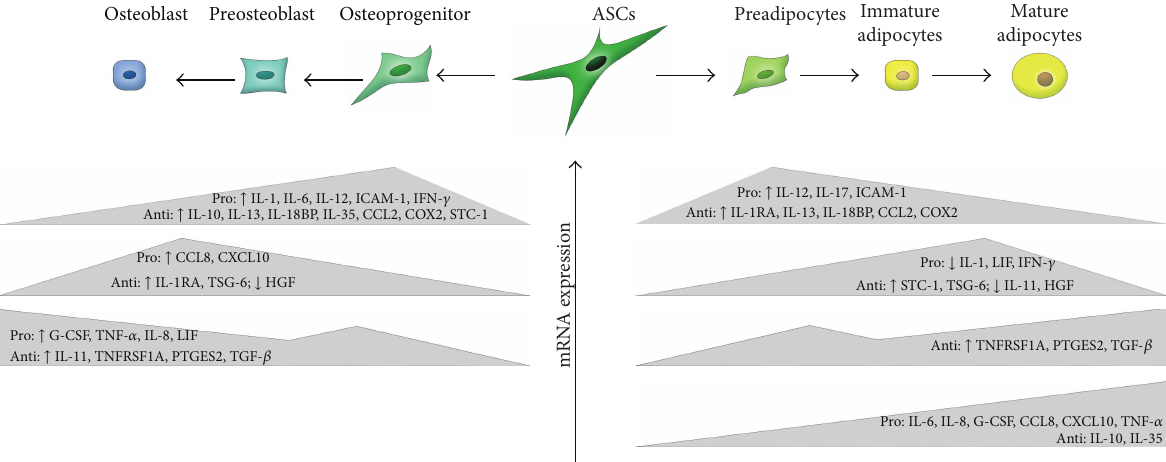
ASCsOsteoprogenitorPreosteoblastOsteoblast